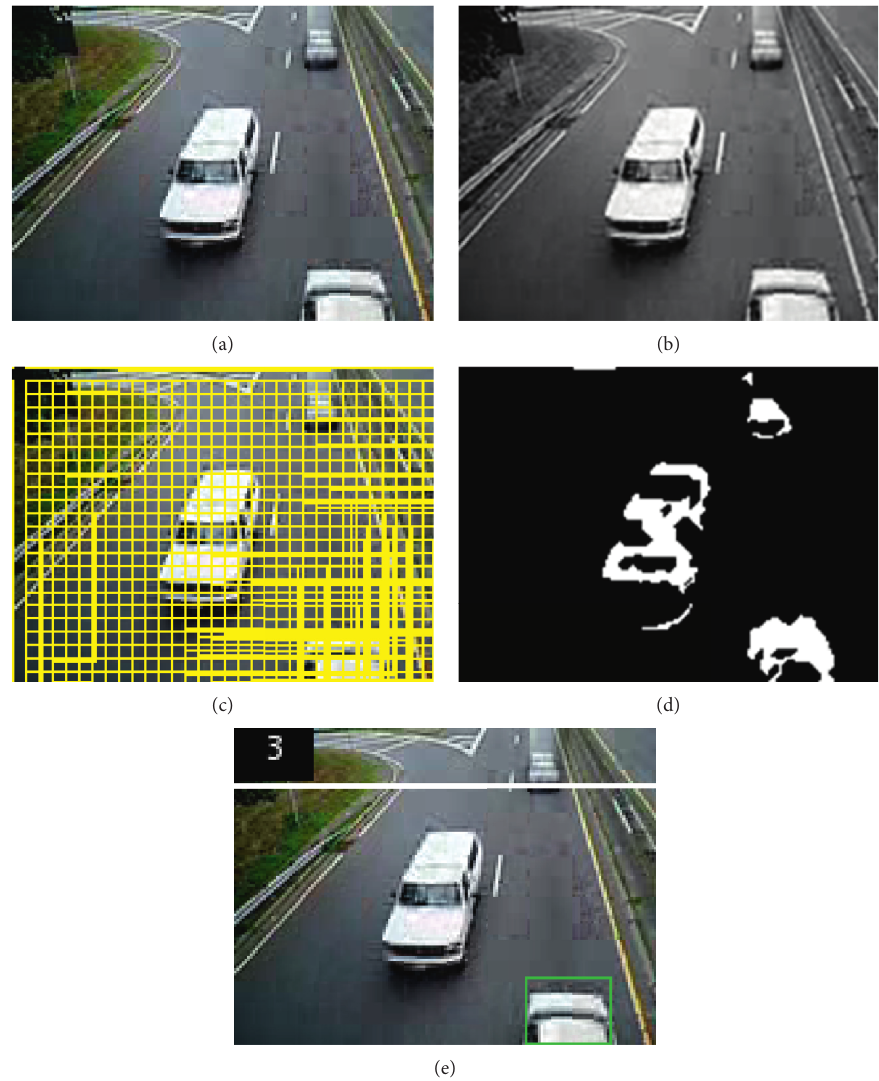
Figure 7: Detection results of the 40 th frame. (a) The original image. (b) Grayscale image. (c) Optical flow vector. (d) Morphological filtering. (e) Test